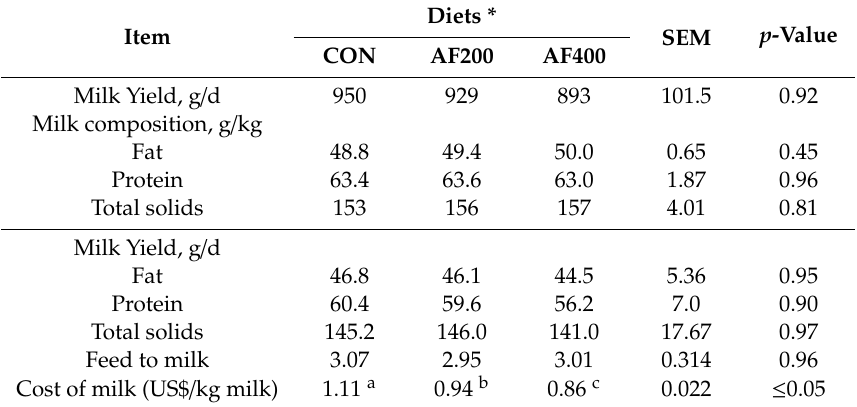
Table 4. Milk yield and composition in lactating Awassi ewes fed diets containing alternative feeds (AF). Diets * Item SEM p -Value CON